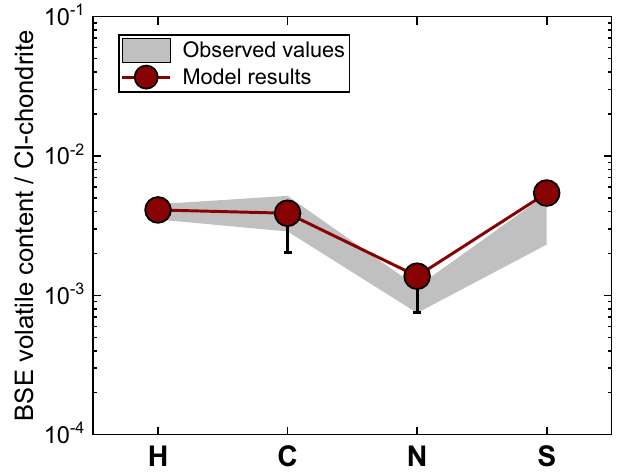
Fig. 6 | Comparison between our modeled volatile contents and the observed values in the bulk silicate Earth (BSE). The observed C, N, and H contents in Earth ’ s present-day BSE were taken from ref. 51, and the S content in BSE were calculated based on refs. 58,59. Note that our modeled H – C – N – S contents are in good agreement with the observed values in the BSE, indicating that the Earth acquired its major volatile inventory through its heterogeneous accretion. Source data are provided in Supplementary Data